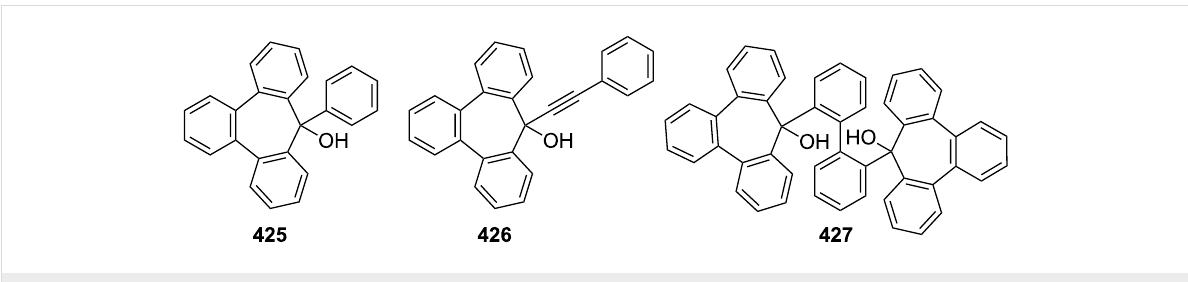
Figure 26: Structures of host molecules 425 – 427 .